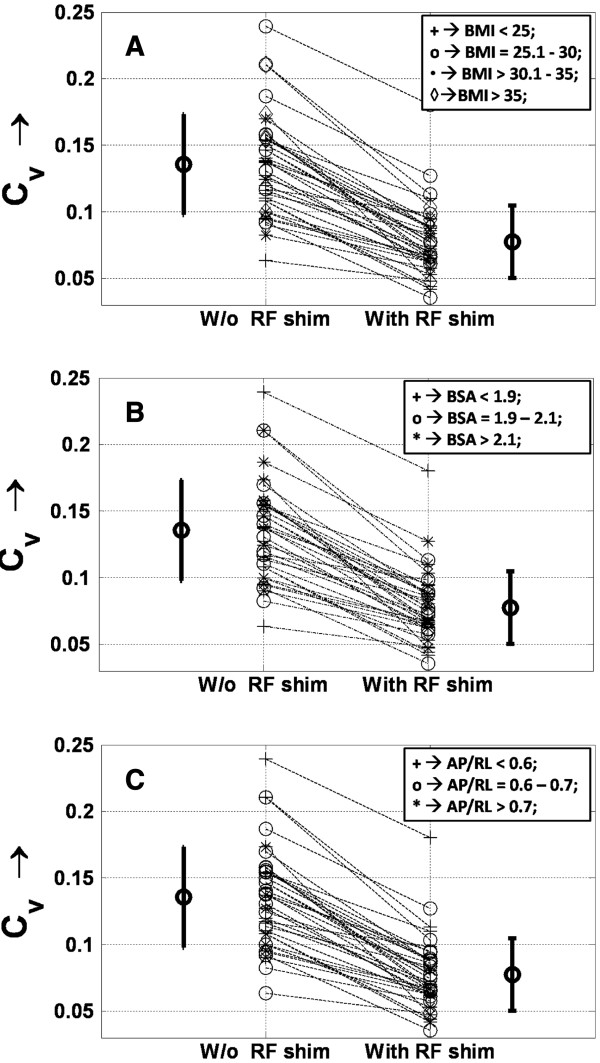
Nomogram plotting the coefficient of signal variation (Cv) across the region of interest for all body types. An average decrease of 42 ± 13% is seen (P < 0.000001; paired Student t test), corresponding to a more uniform B1 field in case of subject-specific radiofrequency (RF) shimming. Changes in Cv with body mass index (BMI) (A), body surface area (BSA) (B), and anterior-posterior/right-left ratio (AP/LR) (C) are shown. As with the mean flip angle, a reduction in Cv is not dependent on body type. The number of subjects with 1a) BMI < 25 kg/m2:14; 1b) BMI = 25.1–30 kg/m2:9; 1c) BMI =30.1–35 kg/m2:7; 1d) BMI > 35 kg/m2:7; 2a) BSA < 1.9 m2: 11; 2b) BSA = 1.9–2.1 m2: 11; 2c) BSA> 2.1 m2:15; 3a) AP/RL < 0.6:8; 3b) AP/RL = 0.6–0.7:22 ; 3c) AP/RL >0.7:7. W/o, without.